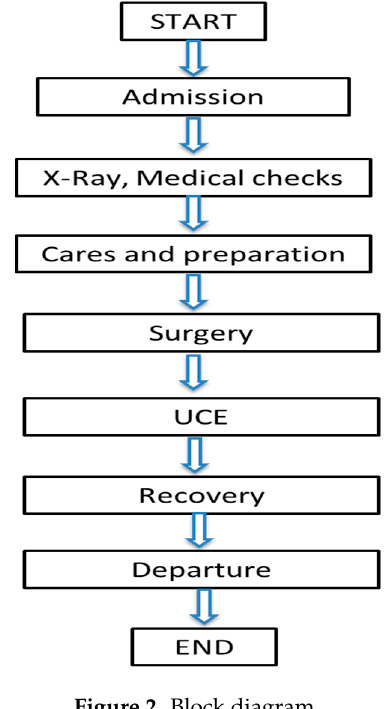
Figure 2. Block diagram.